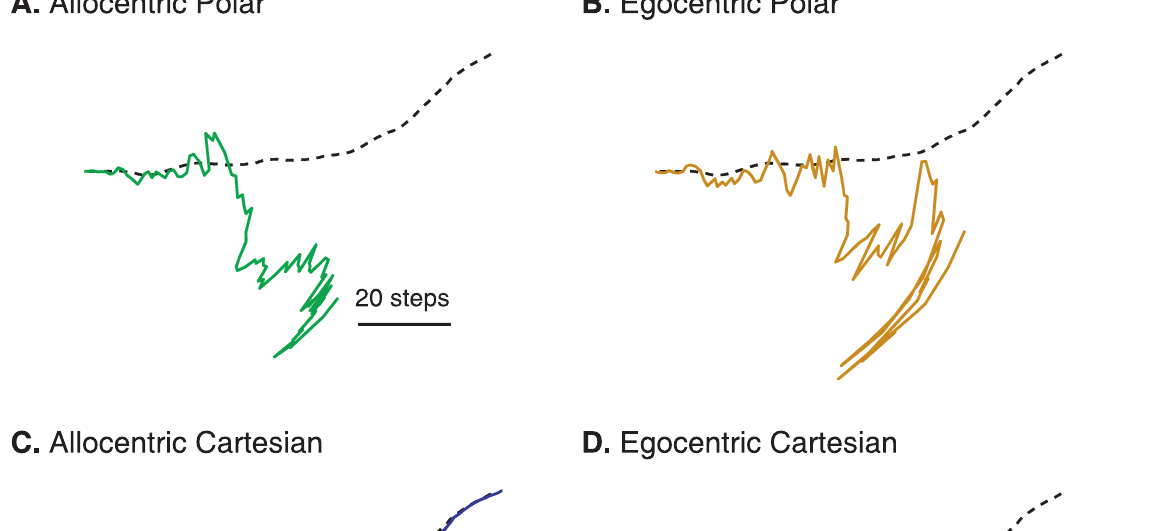
PLoS Computational Biology |